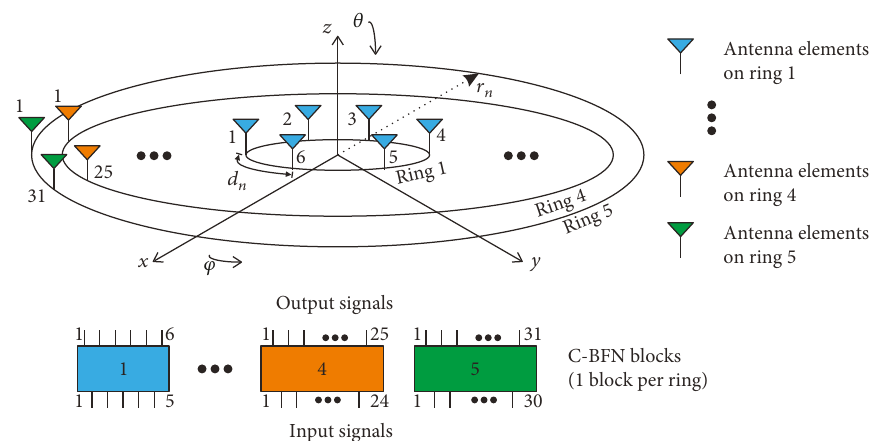
Figure 3: Schematic of the proposed feeding network con fi guration and its interconnection with the aperiodic concentric ring